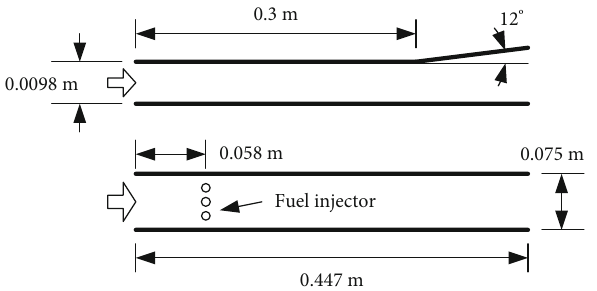
Figure 7: Geometry con fi guration of the HyShot II scramjet combustor.